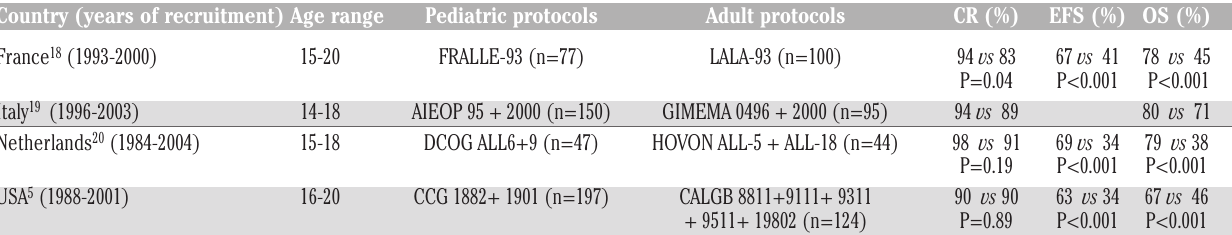
Table 2. Outcomes in adolescents and young adults patients receiving a pediatric or an adult regimen. The comparison of complete response, event free survival and overall survival rates is reported as pediatric vs adult protocols, respectively. Country (years of recruitment) Age range Pediatric